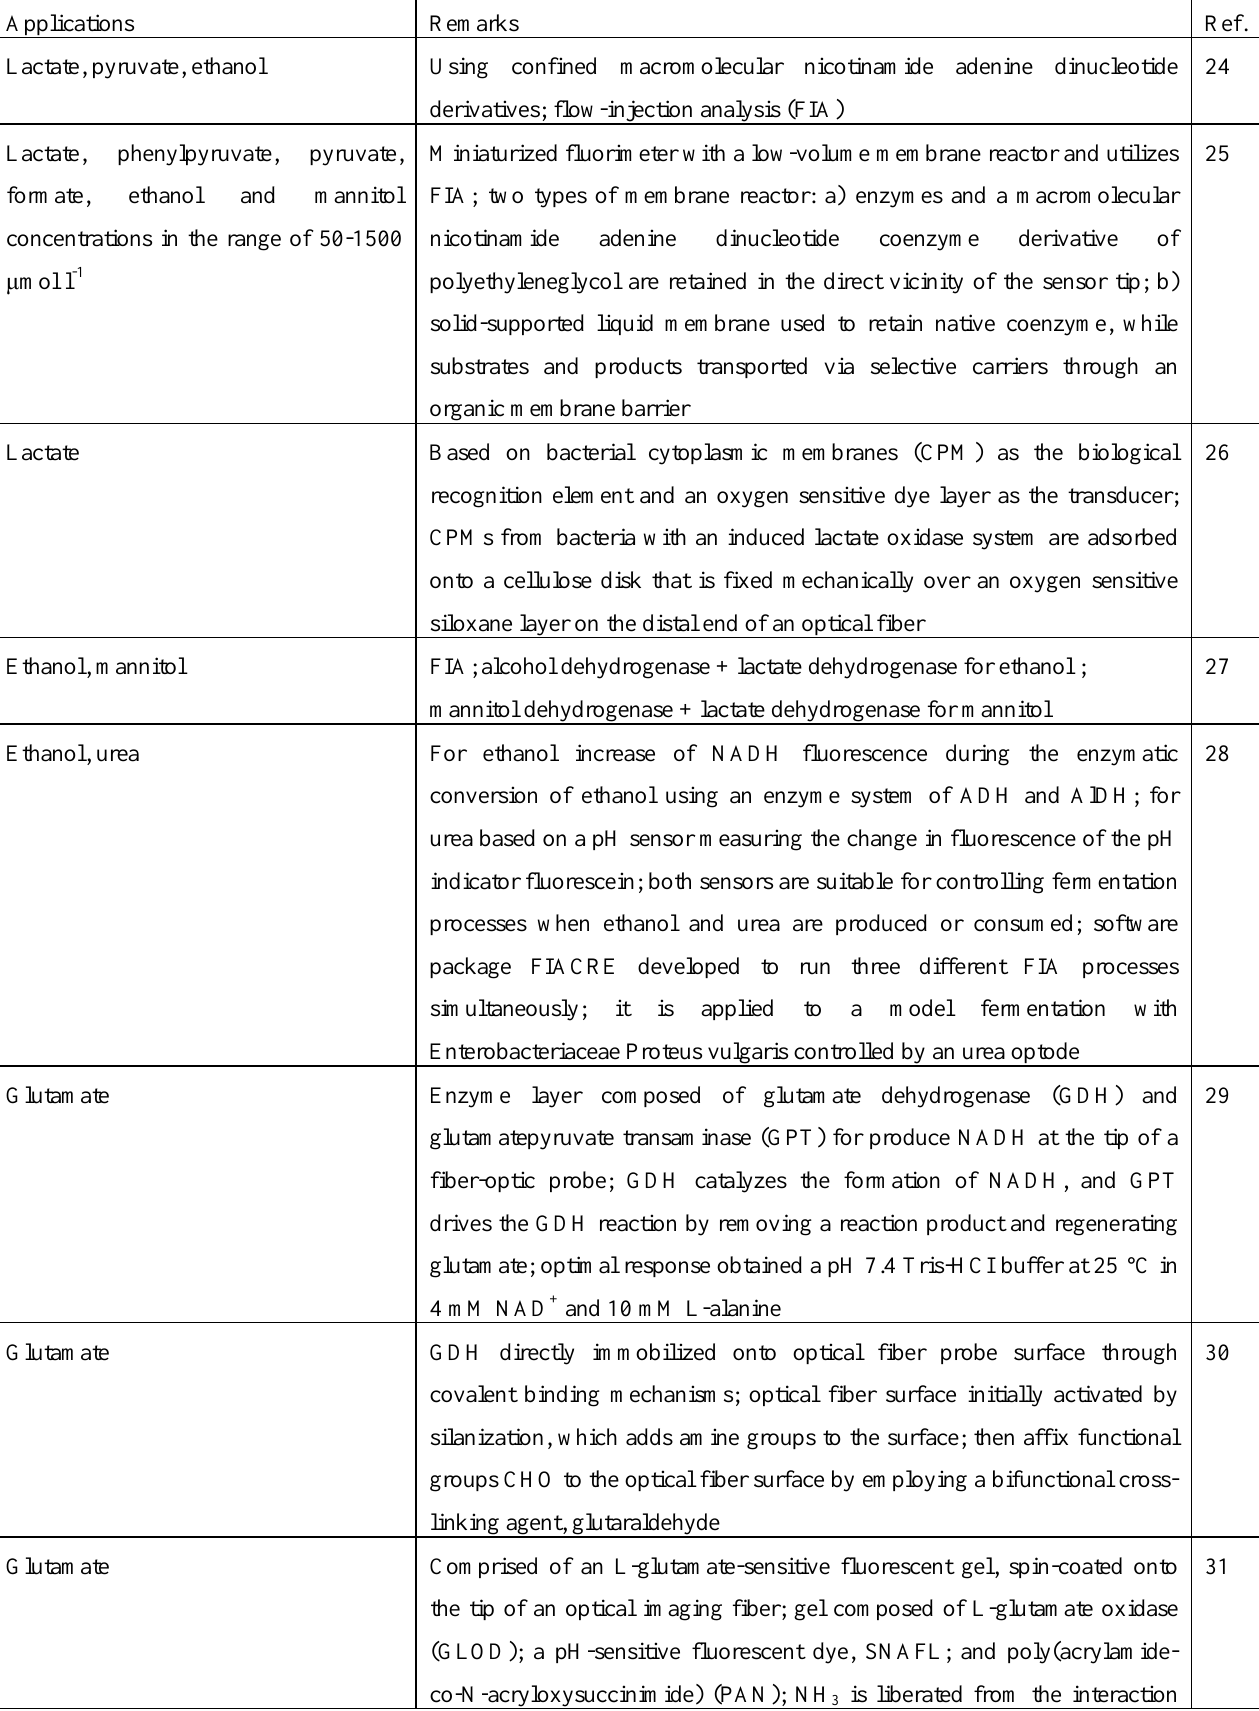
Table 1. Fiber optic biosensors based on fluorescence